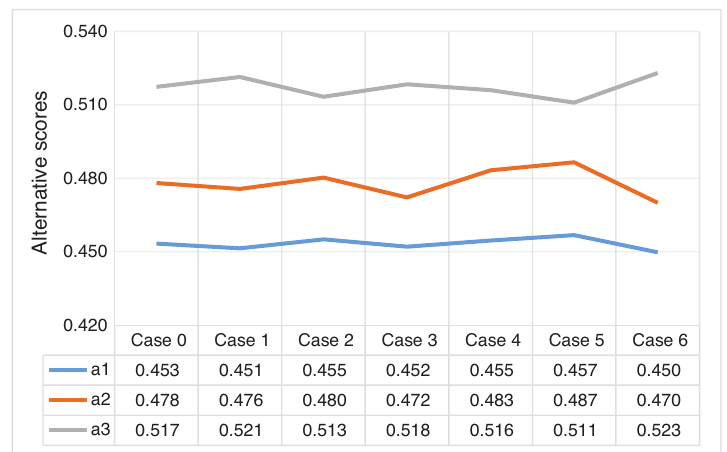
Figure 2: Sensitivity Analysis Results when the Weights of Experts are